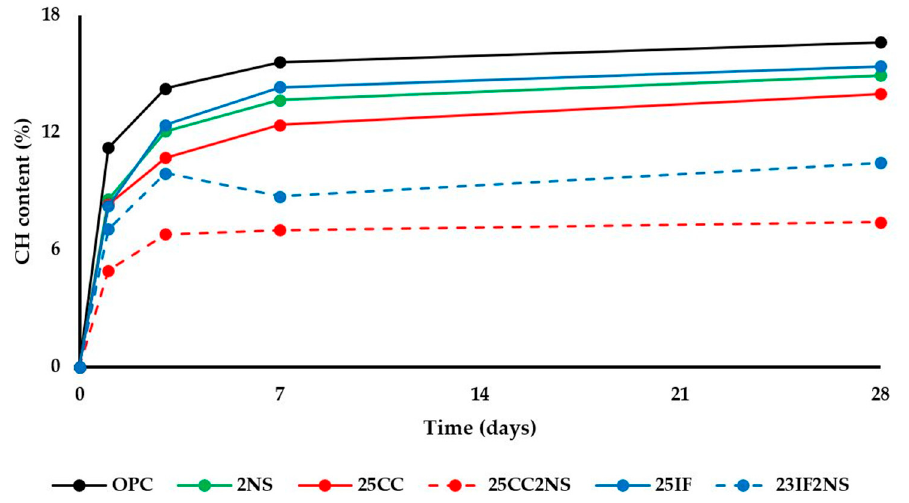
Figure 6. CH content over time for all pastes.